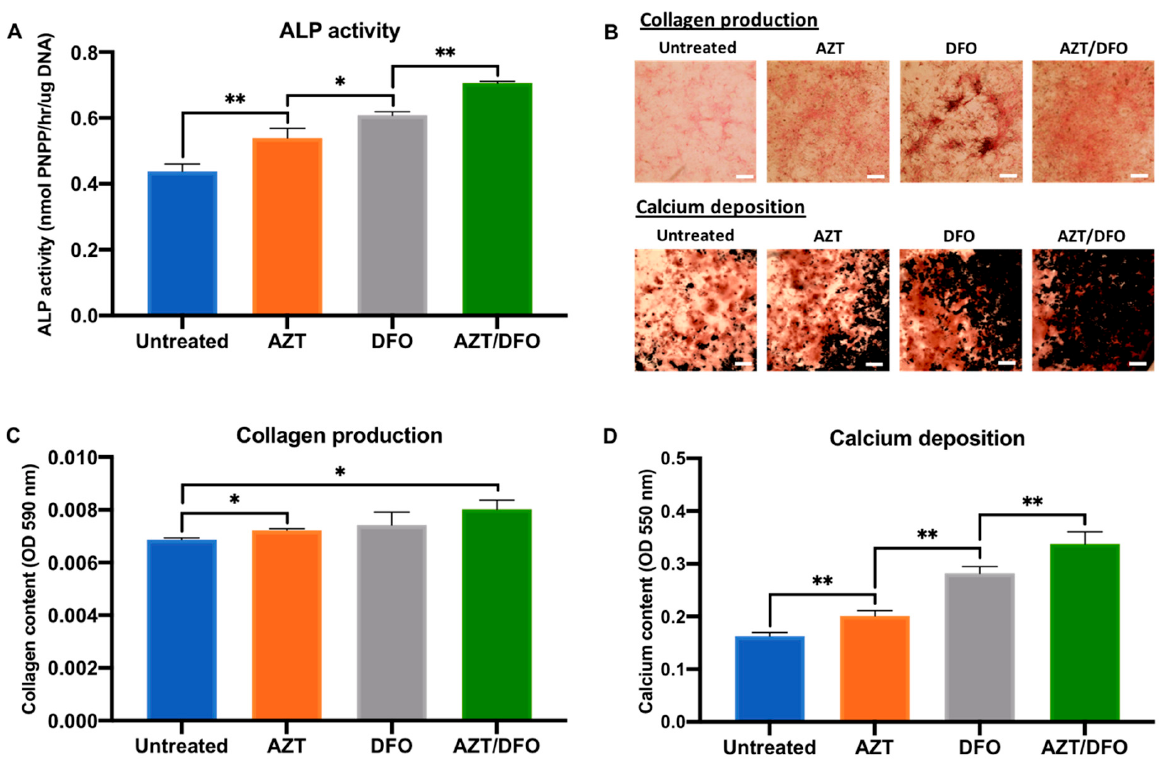
Figure 4. The AZT/DFO combined pre-treatment promoted osteogenic di ff erentiation and extracel- lular matrix mineralisation in hBMSCs. The e ff ects of AZT/DFO on hBMSC ( A ) ALP activity, ( B , C ) collagen production and ( B , D ) calcium deposition. Black staining indicates mineral nodule for- mation. Scale bar = 200 µm. Data are expressed as mean ± SD ( n = 3). * p ≤ 0.05 and ** p ≤ 0.01.